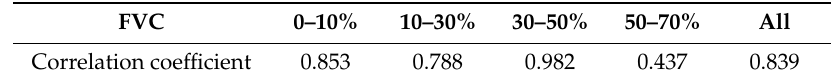
Figure 10. Variation of the spatial distribution of vegetation coverage near the Qingtu Lake wetland. Table 2. Correlation Coe ffi cients Between Di ff erent FVC Ranges and the Surface Area of the Water Body Formed by the Water